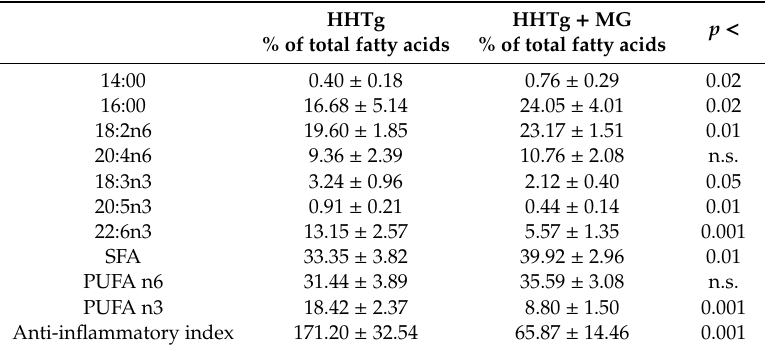
171.20 ± 32.54 65.87 ± 14.46 0.001 Data are given as the mean ± SD, with n = 8 for each group. The relative concentration of each group was calculated as the proportion of all fatty acids detected to the percentage of total fatty acids. Statistical significance was calculated using the two-tailed unpaired Student’s t -test. Anti-inflammatory index = (22:6 n3 + 22:5 n3 + 20:3 n6 + 20:5 n3) / 20:4 n6.